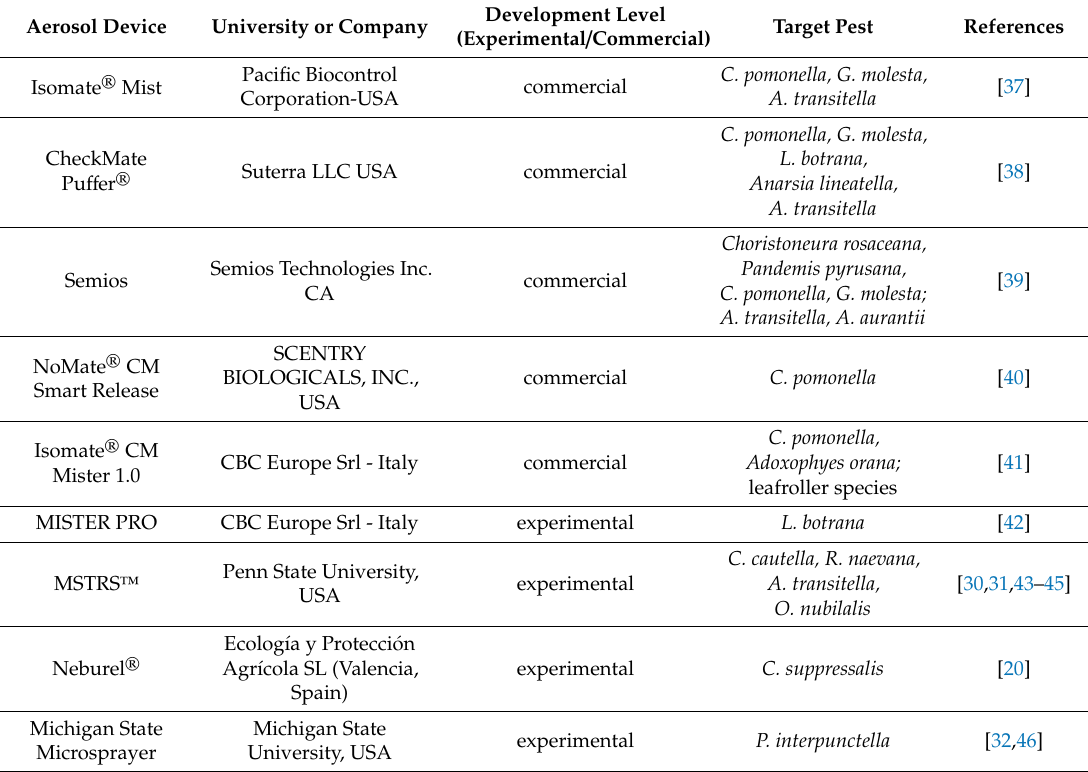
Table 1. Commercial and experimental aerosol devices available or tested so far for field mating disruption of agricultural insect